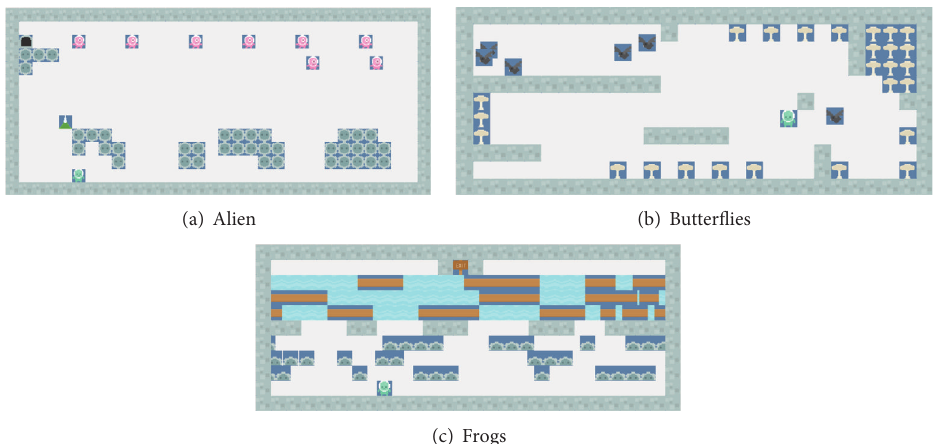
Figure 6: Examples of types of games in the GVG-AI competition platform.